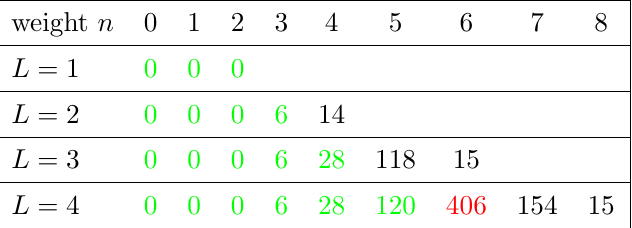
Table 3 . Number of independent parity-odd f n; 1 ; 1 ; : : : ; 1 g coproducts of the MHV and NMHV seven-point amplitudes together through L = 4 loops. A green number denotes saturation of the space constructed from the bottom up. The 406 is discussed in the